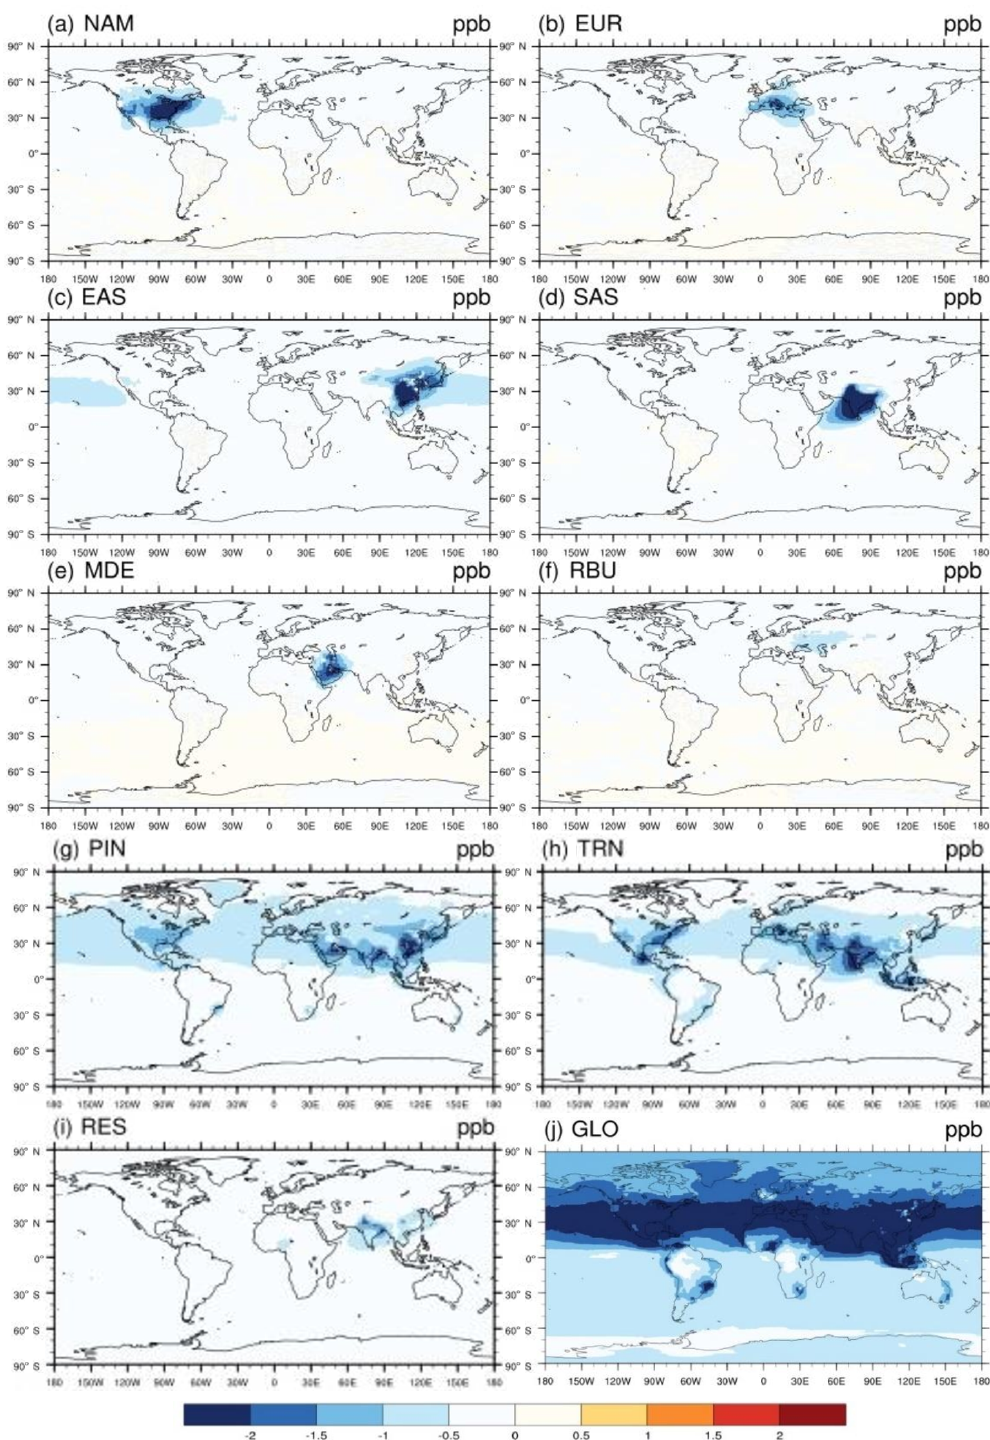
Figure 1. Global difference in multi-model mean O 3 concentrations (ppb) in 20% emission reduction scenarios relative to the baseline for the year 2010 in (a) North America (NAM), (b) Europe (EUR), (c) East Asia (EAS), (d) South Asia (SAS), (e) the Middle East (MDE), and (f) Russia–Belarus–Ukraine (RBU), the (g) power and industry (PIN), (h) transportation (TRN), and (i) residential (RES) sectors, and (j) globally (GLO), shown for the 6-month O 3 season average of 1h daily maximum health-relevant